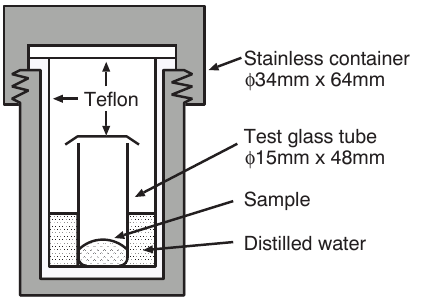
Figure 1. A schematic view of the device for the crystal- lization experiment.